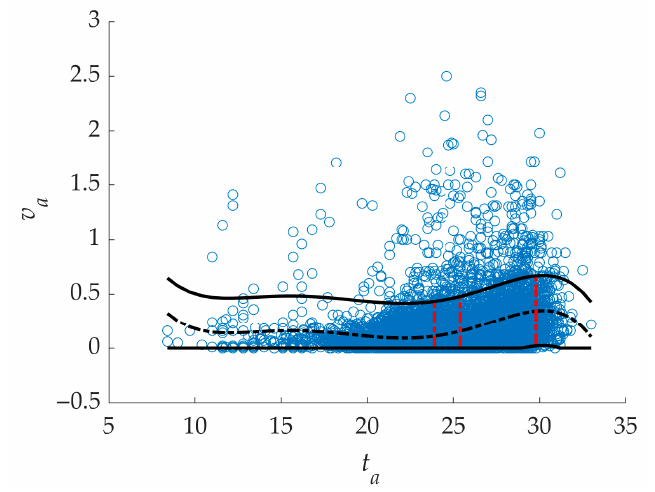
Figure 5. Adjustable interval for air velocity. The middle dashed line is the fitting curve of data, the upper and lower two lines of the three curves represent the envelope curve. (The lower curve represents the constrained envelope curve with t a ≥ 0).